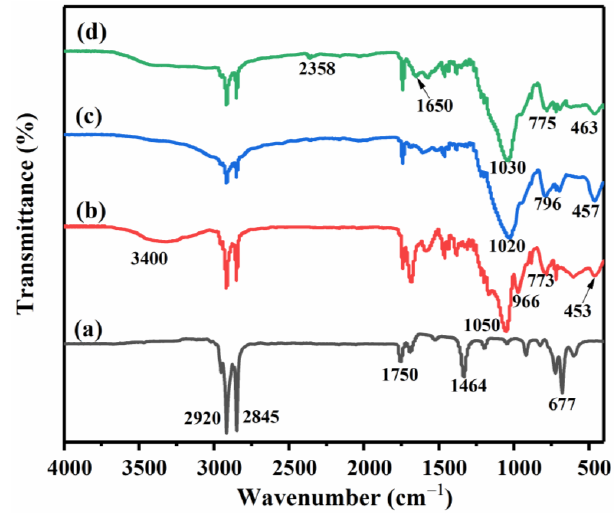
Figure 7. Infrared absorption spectrum of pristine paraffin (a), paraffin@SiO 2 microcapsules (b), paraffin@SiO 2 modified microcapsules (c), and paraffin@SiO 2 colored microcapsules (d).